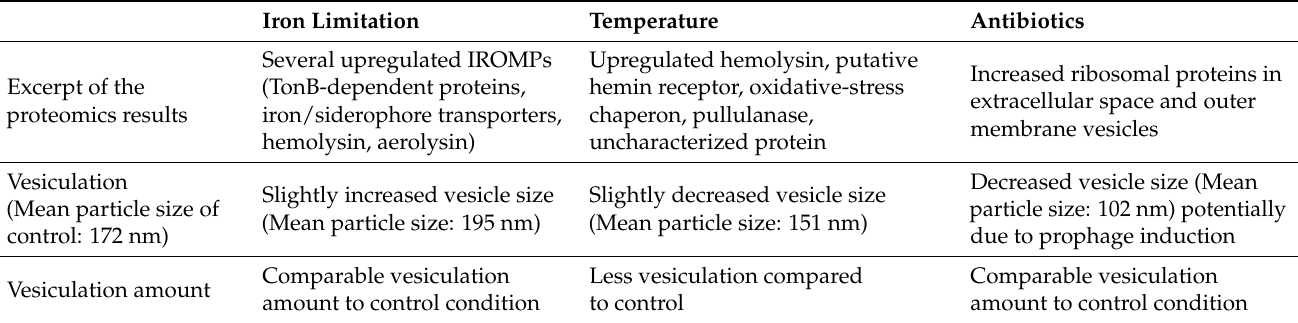
Table 1. Summary of the most important variations between the tested